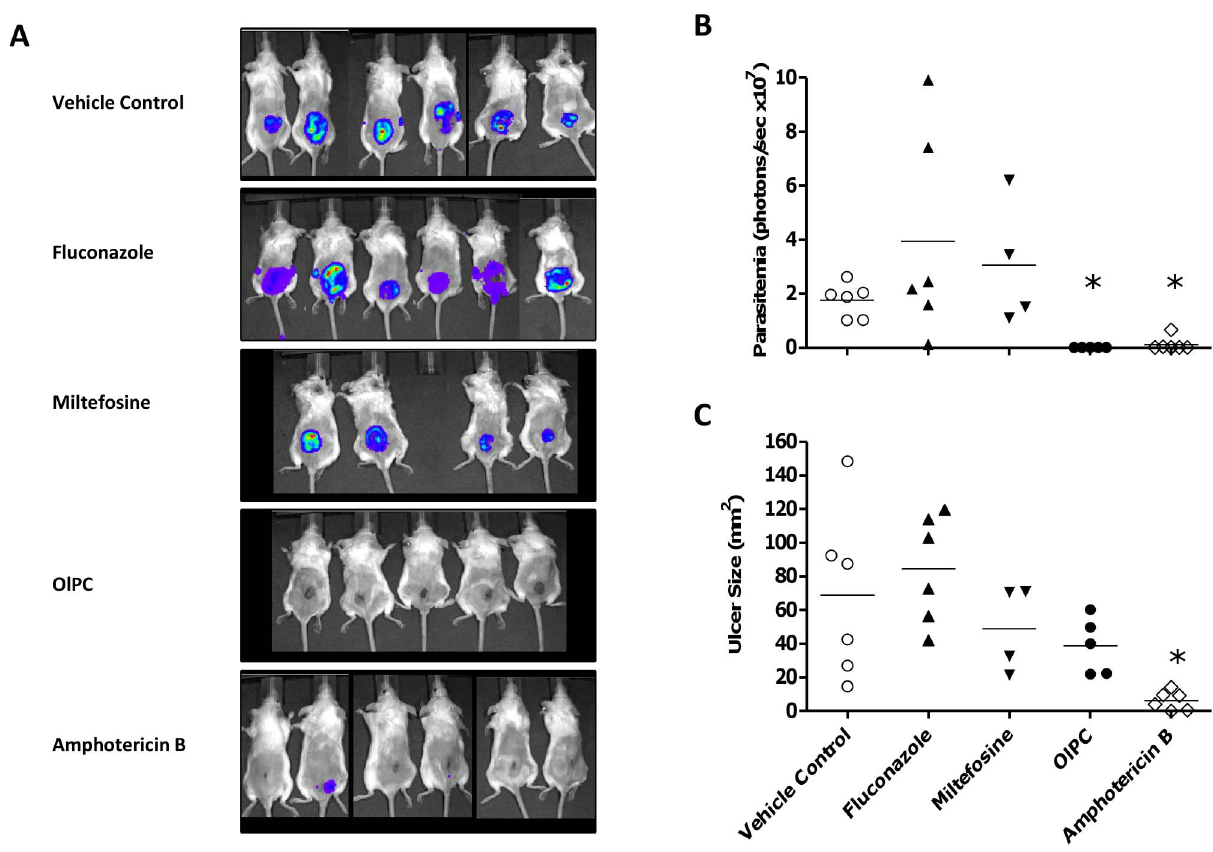
Figure 2. Individual parasitemia and ulcer sizes on Day 19 post treatment start. L. major infected BALB/c mice were treated with PBS vehicle control (oral), OlPC (oral, 40 mg/kg/day 6 21 days), miltefosine (oral, 40 mg/kg/day 6 21 days), fluconazole (oral, 160 mg/kg/day 6 21 days) and amphotericin B (IP, 25 mg/kg/day 6 10 days). Parasitemia (A and B) were measured on Day 19 using in vivo imaging technology (IVIS) and ulcer sizes were measured using a calibrated digital caliper (C). Means are shown as horizontal lines (B and C). * P , 0.05 compared to vehicle